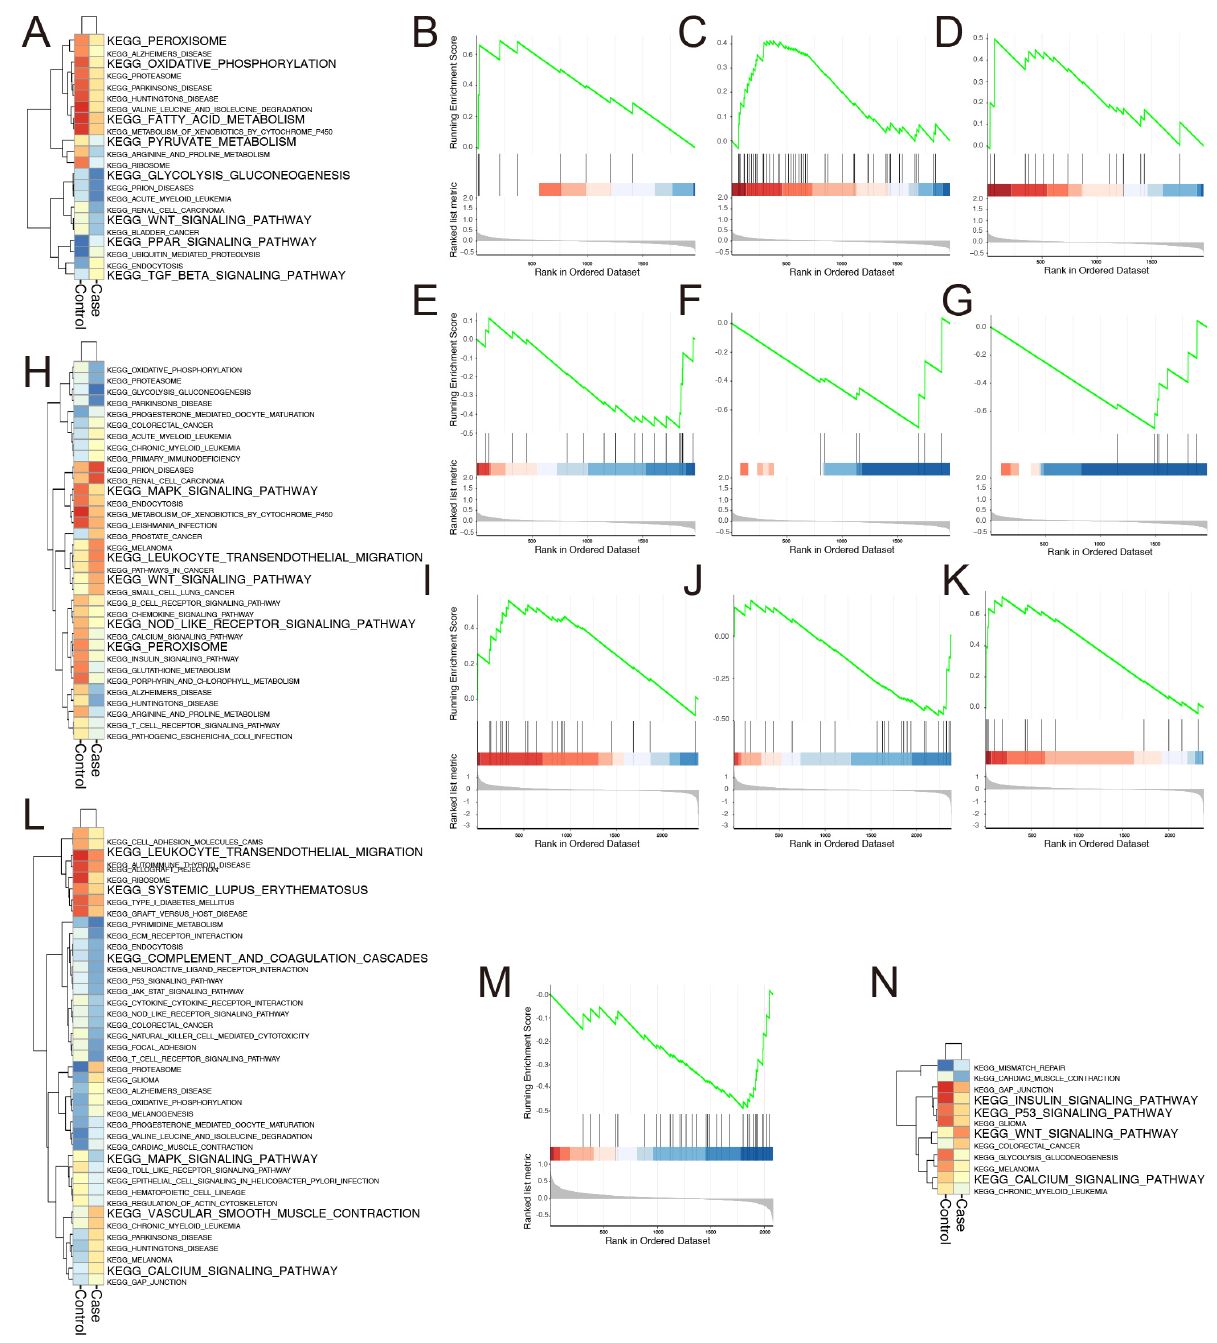
Figure 6. The results of GSVA and GSEA of erythroblast and monocyte-derived macrophage and immature B cell. The substance metabolism-associated pathways uncovered by GSVA for erythroblast ( A ). GSEA of erythroblast, showing adipocytokine, P53 signaling pathways, leukocyte trans-endothelial migration, citrate cycle TCA cycle, glutathione metabolism, and cell cycle, respectively ( B – G ). The inflammatory response-related pathways analyzed by GSVA for monocyte-derived macrophage ( H ). GSEA of monocyte-derived macrophage, showing JAK-STAT, systemic lupus erythematosus, and complement and coagulation cascades, respectively ( I – K ). Vascular injury and bone metabolism correlative pathways of immature B cell ( L ). The repressed lysosome pathway of neutrophil in the case group revealed by GSEA ( M ). Cell proliferation and apoptosis-related signaling pathways demonstrated by GSVA ( N ).